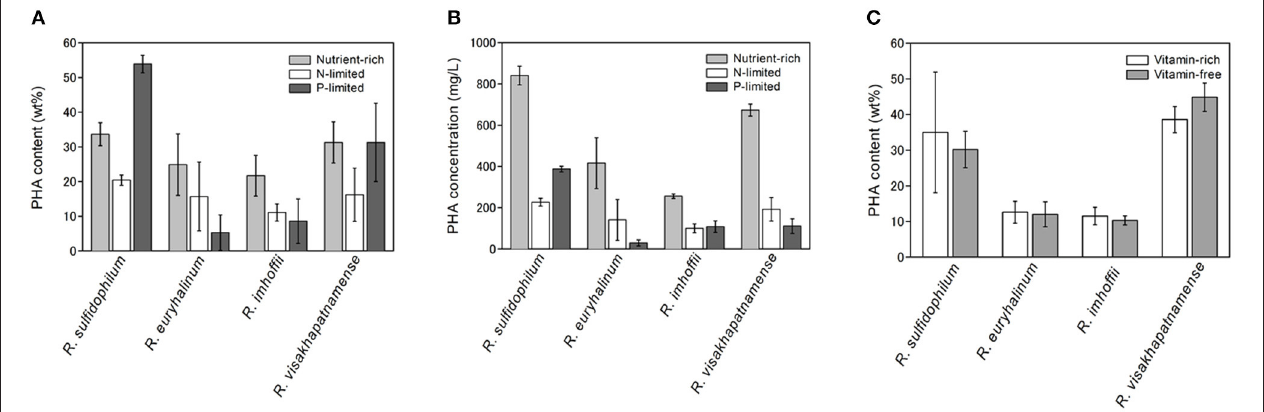
FIGURE 1 | PHA production under nutrient limited conditions. (A) PHA content (wt%) and (B) PHA concentrations (mg/L) under nutrient-rich and nutrient-limited conditions. Four marine purple non-sulfur bacterial strains ( R. sulfidophilum , R. euryhalinum , R. imhoffii and R. visakhapatnamense ) were cultured in growth medium and then inoculated in nitrogen-limited (white bars) or phosphate-limited (dark gray bars) medium supplemented with 0.5% sodium acetate and in growth medium (light gray bars). (C) PHA content (wt%) under vitamin-free (light gray bars) and vitamin-rich (white bars) conditions. Data are the mean ± SD of at least three cultures.